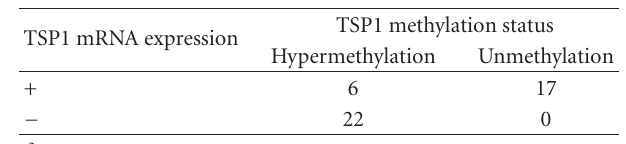
Table 2: Methylation status and mRNA expression of TSP1 in GCA